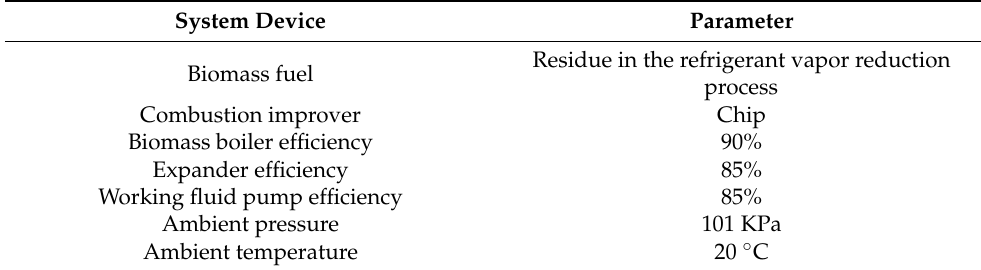
Table 2. Initial operation parameters of the system [21].